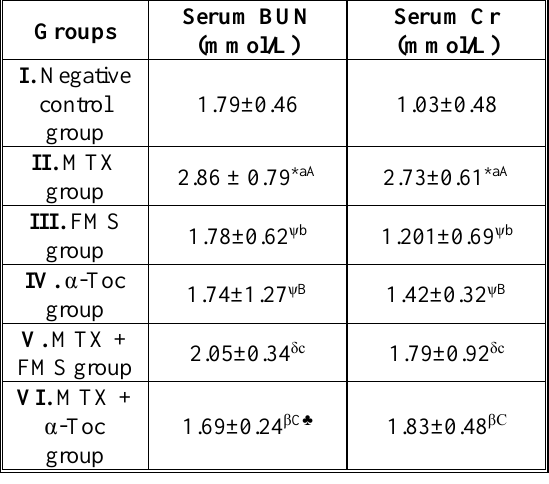
Table 1. Effects of fimasartan on the serum levels of BUN and